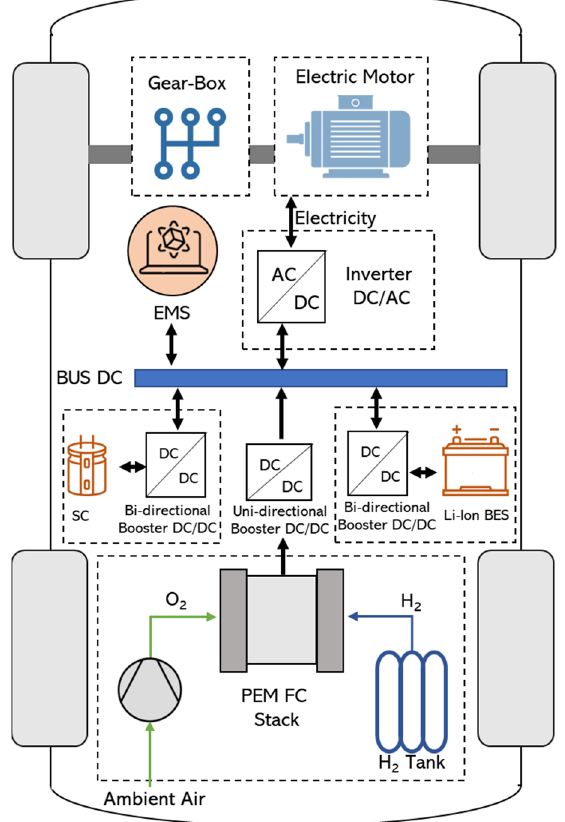
Figure 6. Fuel cell Hybrid Electric Vehicle Configuration, with Fuel Cell, Battery, and Super-Capacitor Energy Systems.